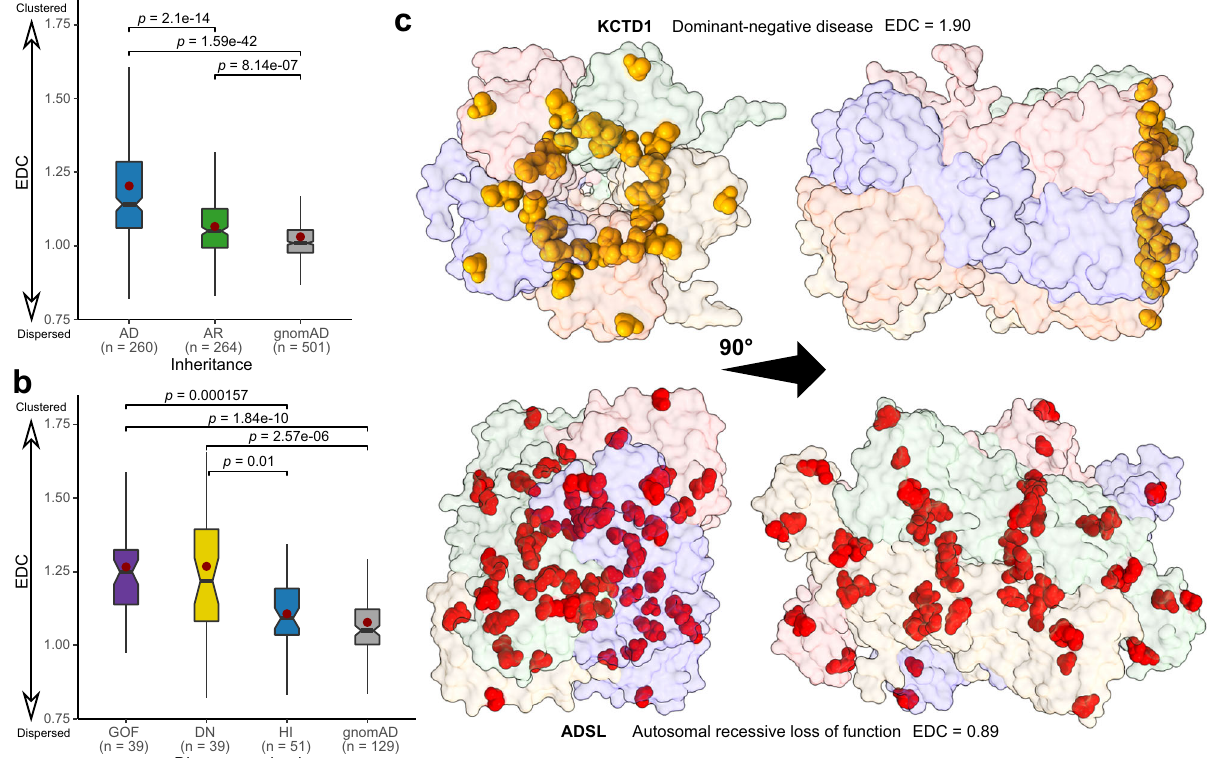
Fig. 6 Pathogenic mutations in genes associated with dominant-negative and gain-of-function mechanisms are signi fi cantly more clustered in space than those associated with loss-of-function mechanisms. Sample sizes denote protein number. Boxes denote data within 25th and 75th percentiles, and contain median (middle line) and mean (red dot) value notations. Whiskers extend from the box to furthest values within 1.5x the inter-quartile range. a Distribution of Extent of Disease Clustering (EDC) values for autosomal recessive (AR) compared to autosomal dominant (AD) disease genes. EDC values calculated with gnomAD variants from the same set of genes are shown for comparison. p -values were calculated with the two-sided Holm- corrected Dunn ’ s test. EDC values were only calculated for protein structures with pathogenic/gnomAD variants at least 10 different residues, which means that the number of proteins in the gnomAD set is slightly smaller than the sum of the AD and AR groups. b Distribution of EDC values for AD disease genes associated with gain-of-function (GOF), dominant-negative (DN) and haploinsuf fi cient (HI) mechanisms. c Demonstration of the variant distribution differences between non-LOF (KCTD1) and LOF (ADSL) disease proteins, and their strikingly different EDC values. Source data are provided as a Source Data fi